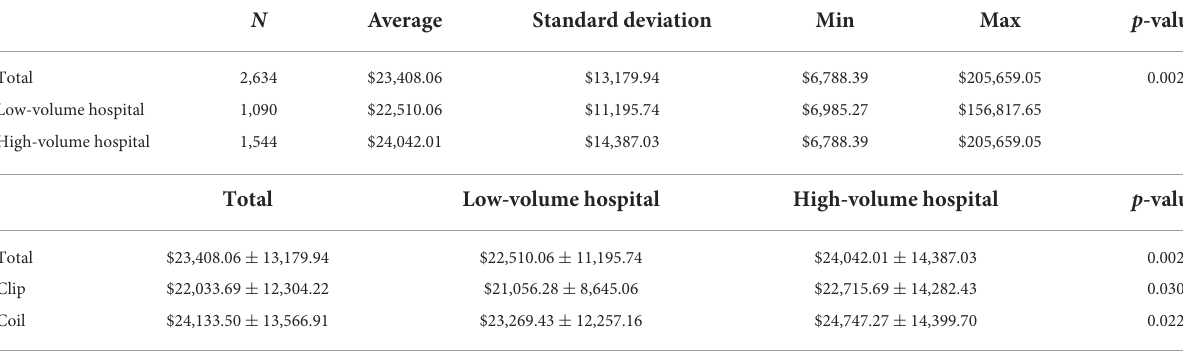
TABLE 3 Hospital costs by hospital volume and surgical treatment of 2,634